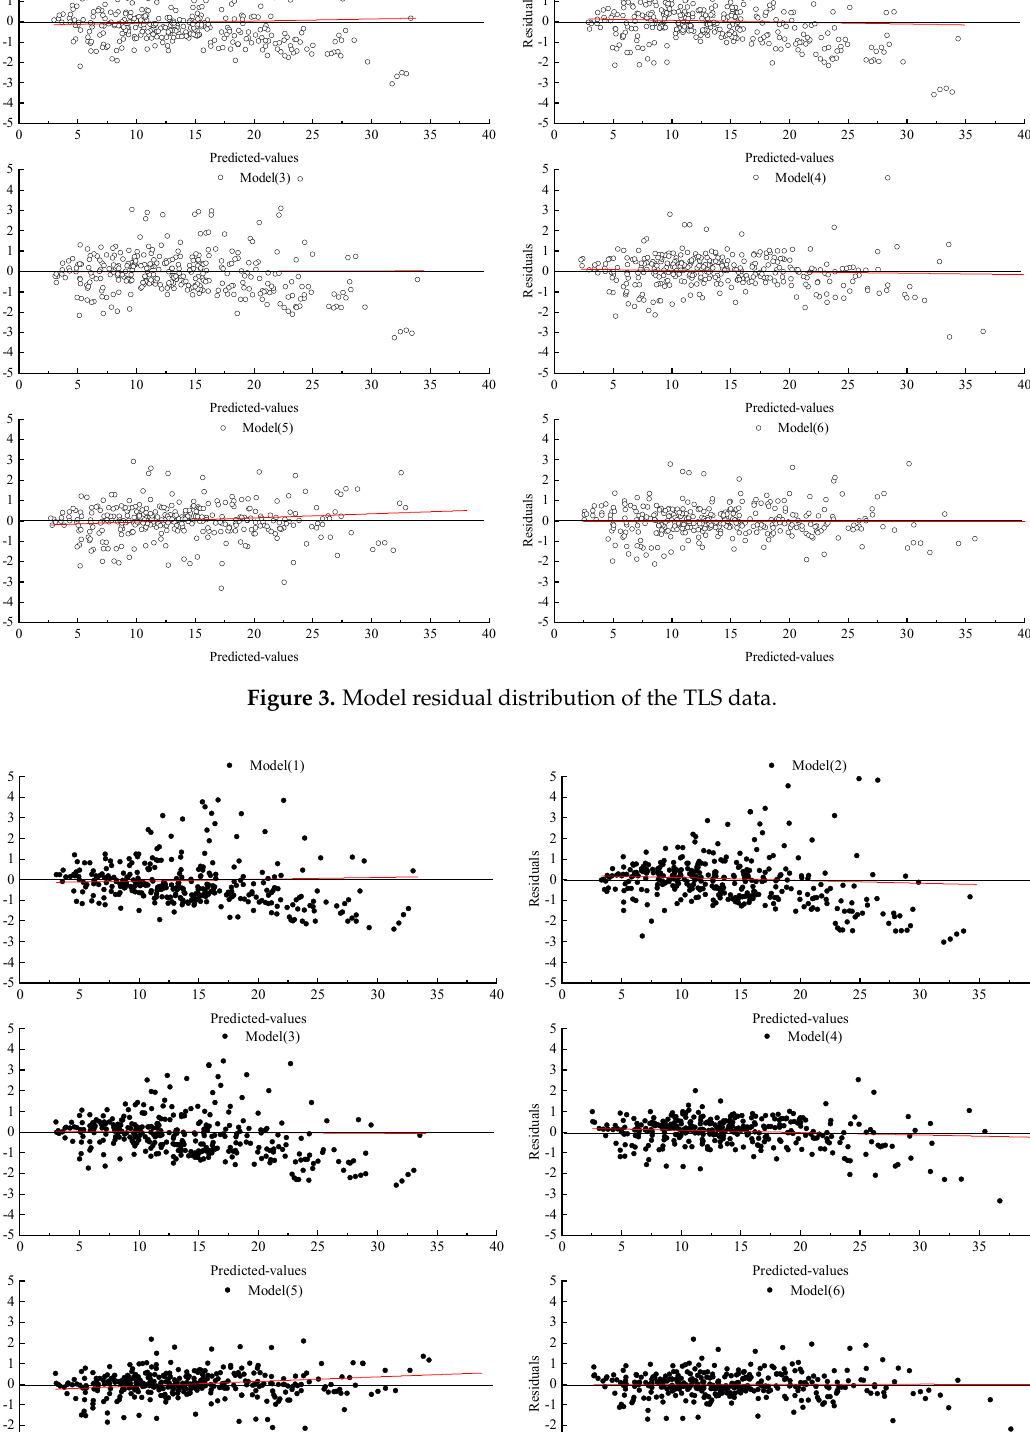
Figure 4. Model residual distribution of the measured stem analysis data.